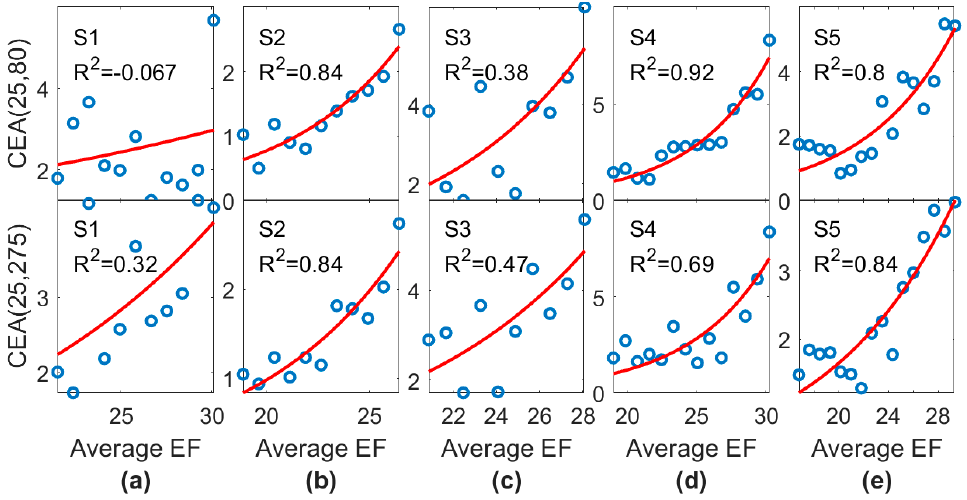
Figure 6. Exponential model fits for the CEA measure vs. the average E-field for each subject separately. ( a – e ) correspond to subjects S1-S5, as indicated by the inset text. Top panels are for CEA(25,80) and bottom panels for CEA(25,275). The adjusted R 2 for each model fit is shown inside each